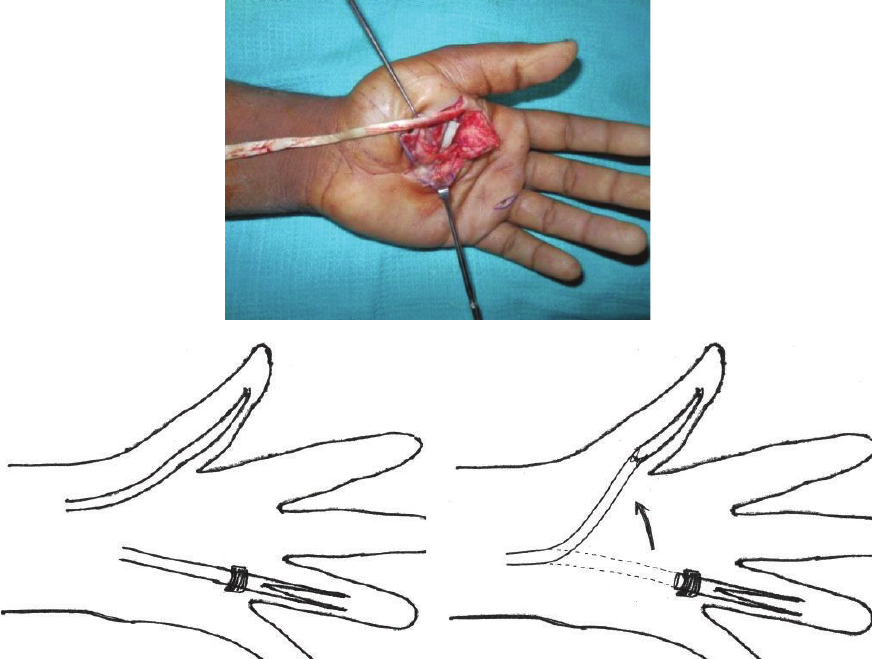
Figure 2: Flexor digitorum superficialis tendon from the ring finger harvested and tunnelled deep to the neurovascular